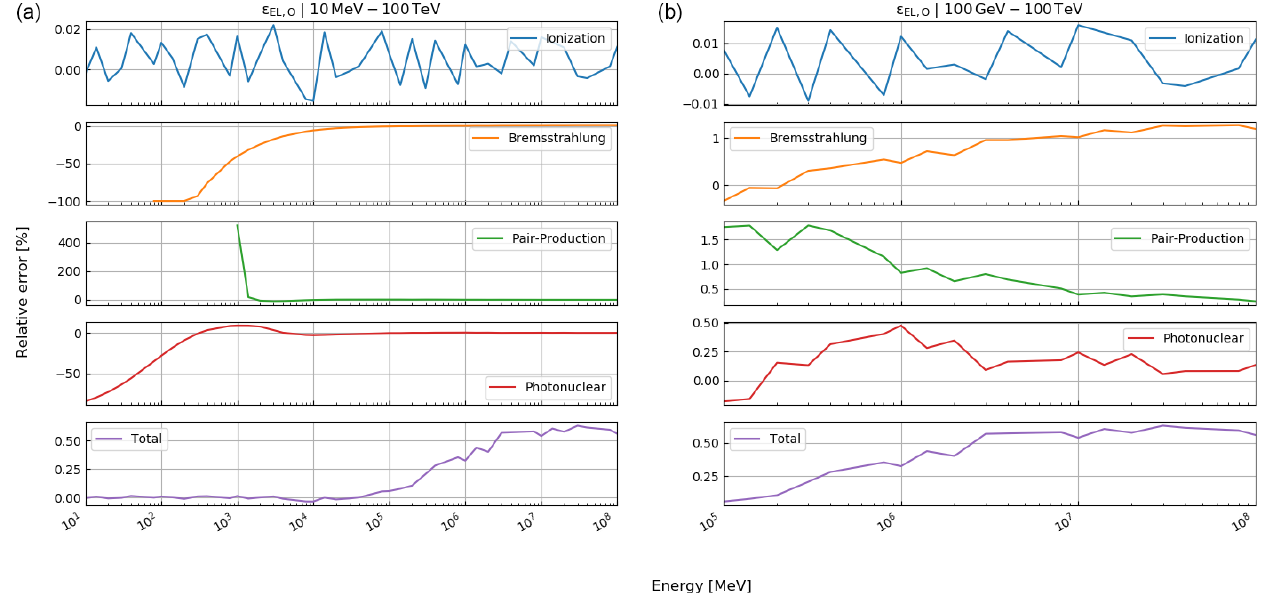
Figure E9. Relative error of our energy loss calculations compared to the tabulated values from Groom et al. (2001) for oxygen in the energy ranges (a) 10MeV–100TeV and (b)